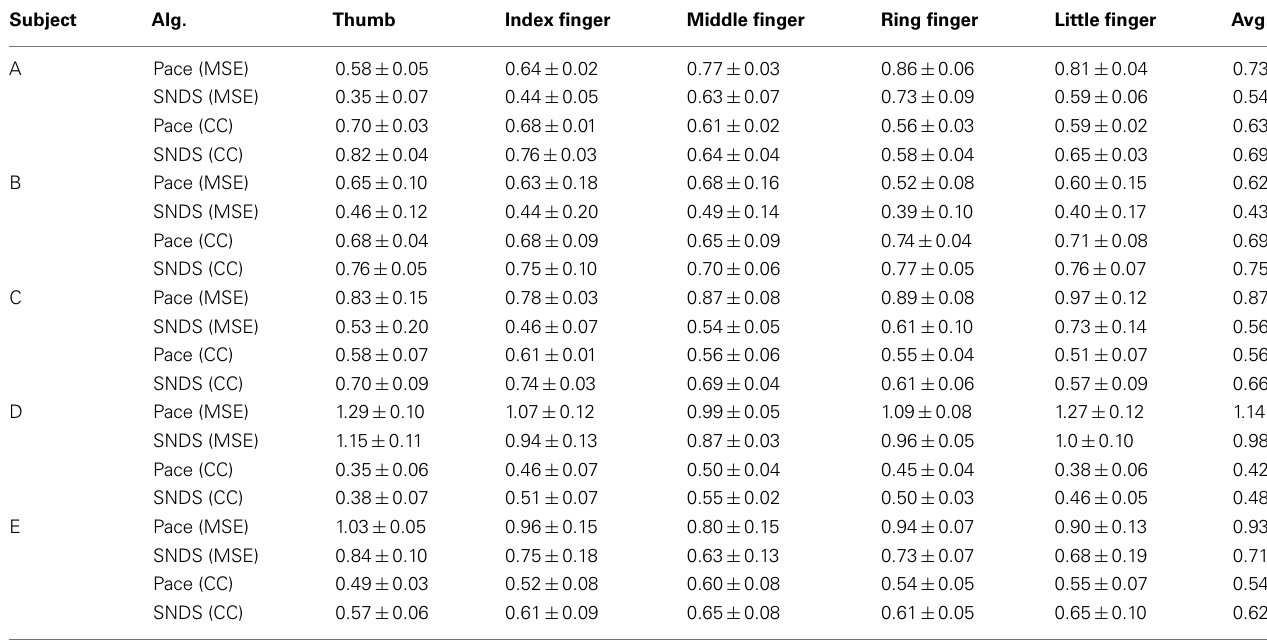
Table 1 | Comparison of decoding performance between pace regression and